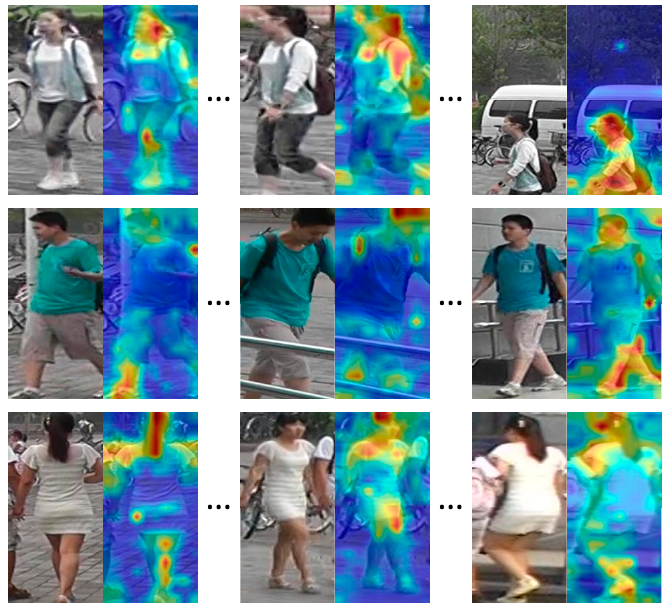
Figure 5. Activation visualisation results from three video sequences.